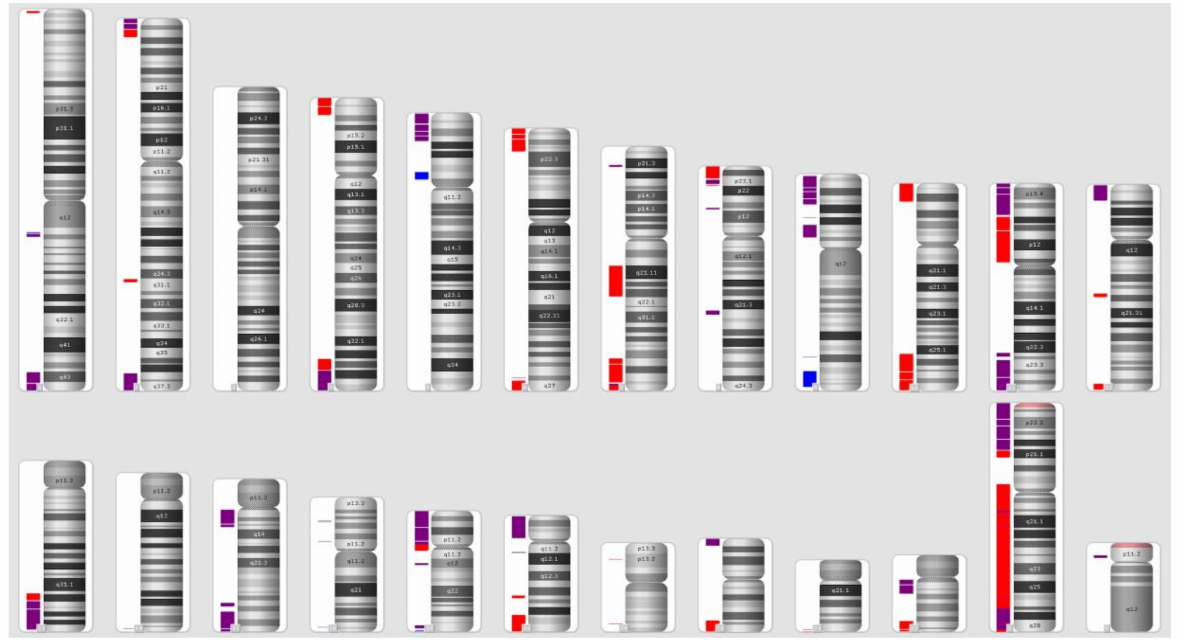
Figure 3. SRO Distribution across the Genome. Red bars indicate SROs composed entirely of deletions while blue bars indicate SROs composed solely of duplications. Purple bars are SROs that feature both deletions and duplications.